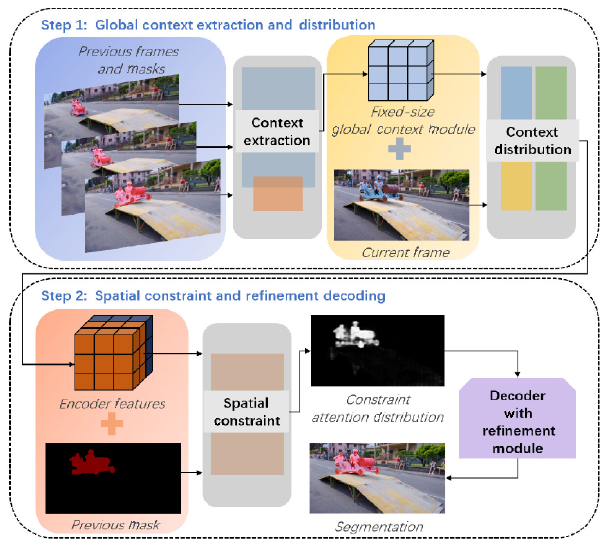
Fig. 1 Our solution has three key steps: (i) Context extraction: extract each frame’s information into a fixed-size updater (see Eqs. (2) and (3)). (ii) Context distribution: match the current frame’s semantic information with that in the updater at pixel level (see Eq. (4)). (iii) Spatial constraint enforcement: the mask of the previous frame is input into the spatial constraint module (see Eq.